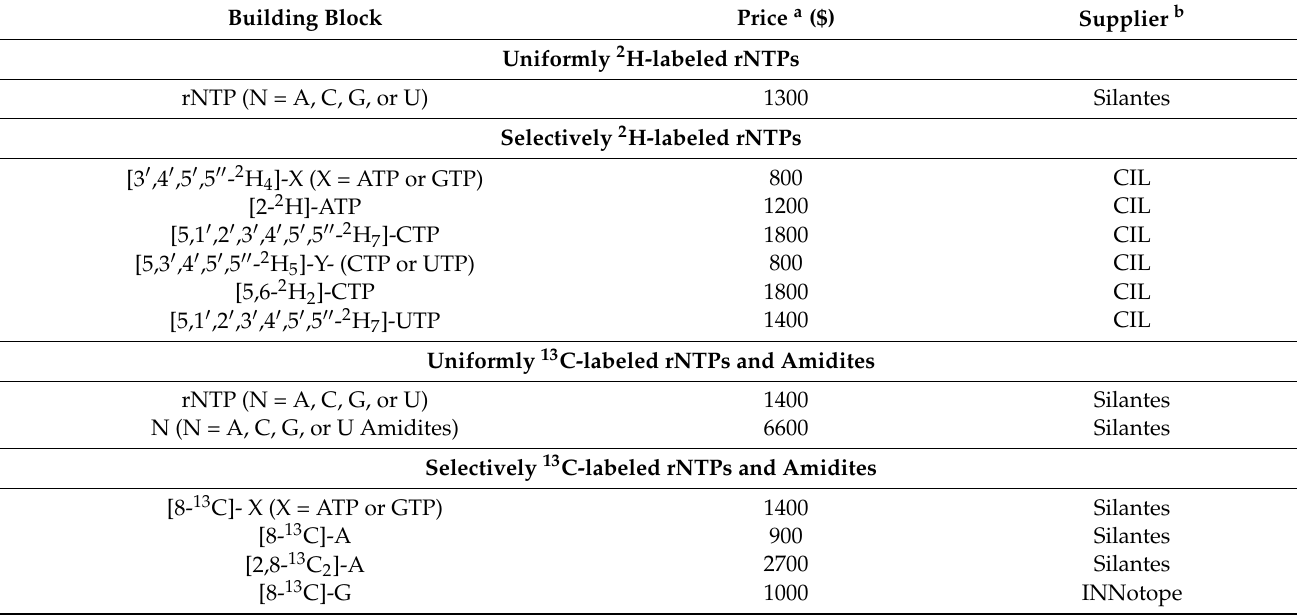
Table 1. Price of commercial isotope-labeled rNTPs and RNA